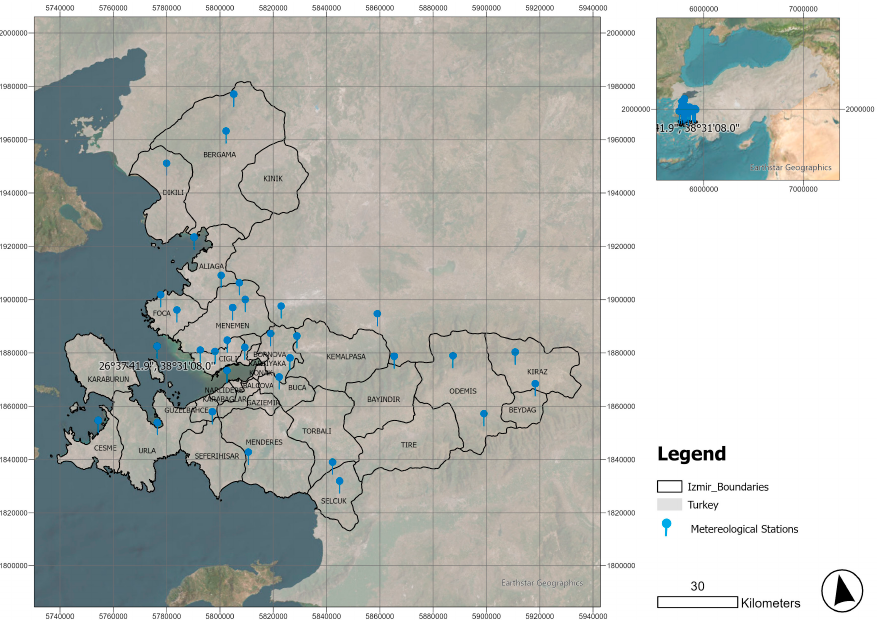
Figure 1. Area of interest. Izmir Metropolitan City (source: author’s elaboration on administrative boundary layers of European Environmental